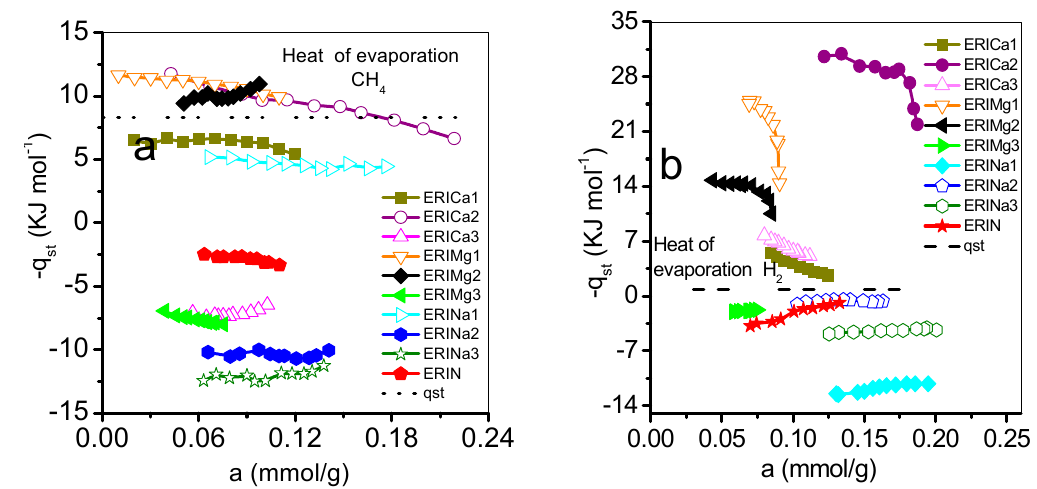
Figure 11. Variation of the isosteric heat of adsorption (-qst) with adsorbate coverage on erionite zeolites: ( a ) CH 4 , ( b ) H 2